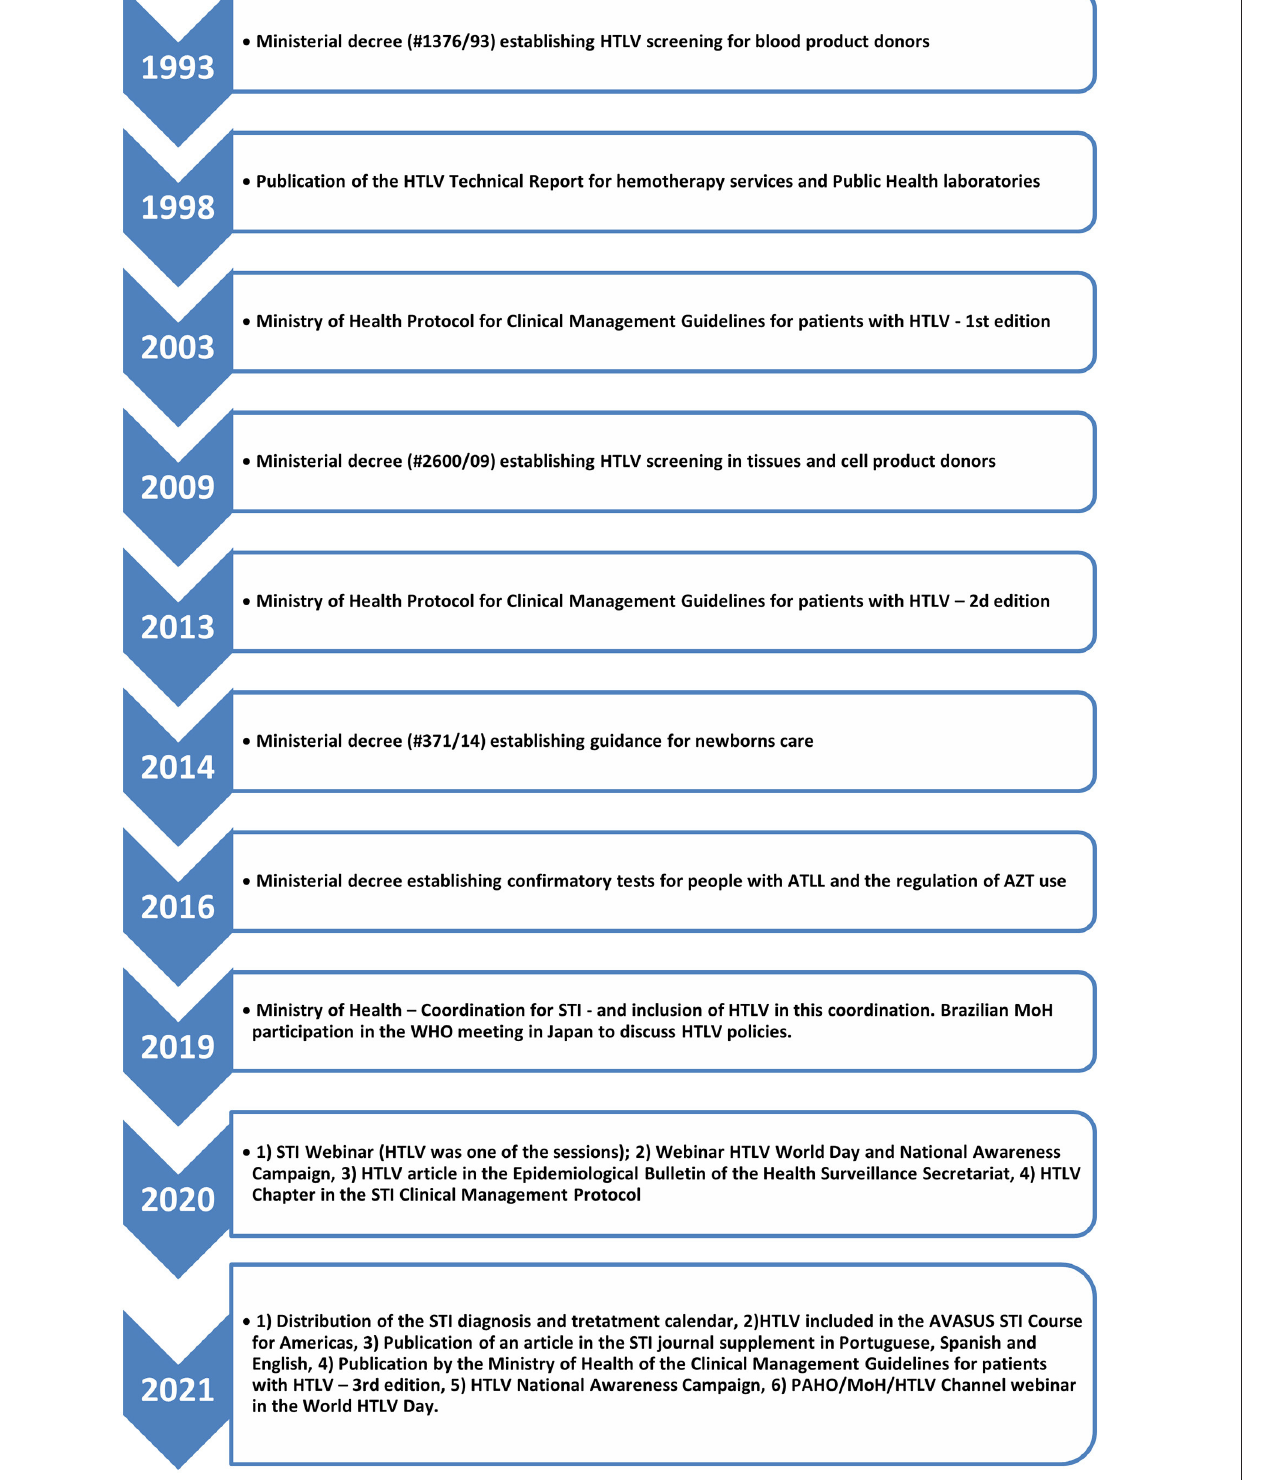
Frontiers in Medicine |